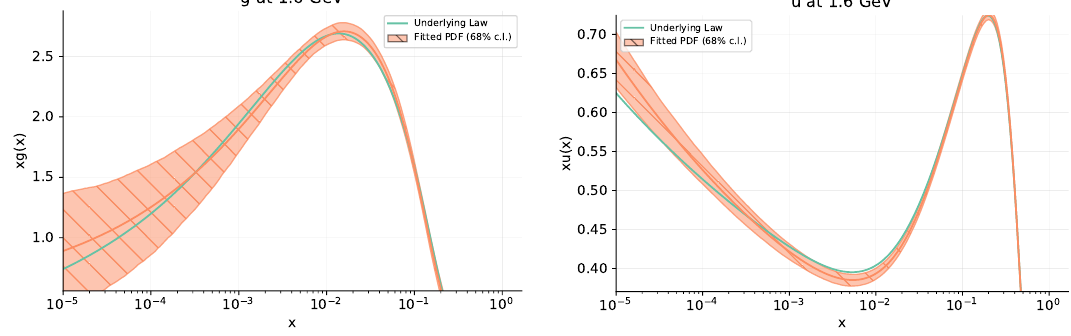
Figure 15 . The gluon (left) and up quark (right) PDFs obtained from the closure test framework in which both the underlying PDF set and Wilson coefficients are known. Shown in green is the PDF replica used as the underlying law which generates the fake data used to train our model. The resulting PDFs are shown in orange along with their 68% confidence level bands. The fake data generated by the underlying law is subsequently modified so as to encode the ( W, Y ) = (1 , − 1) × 10 − 4